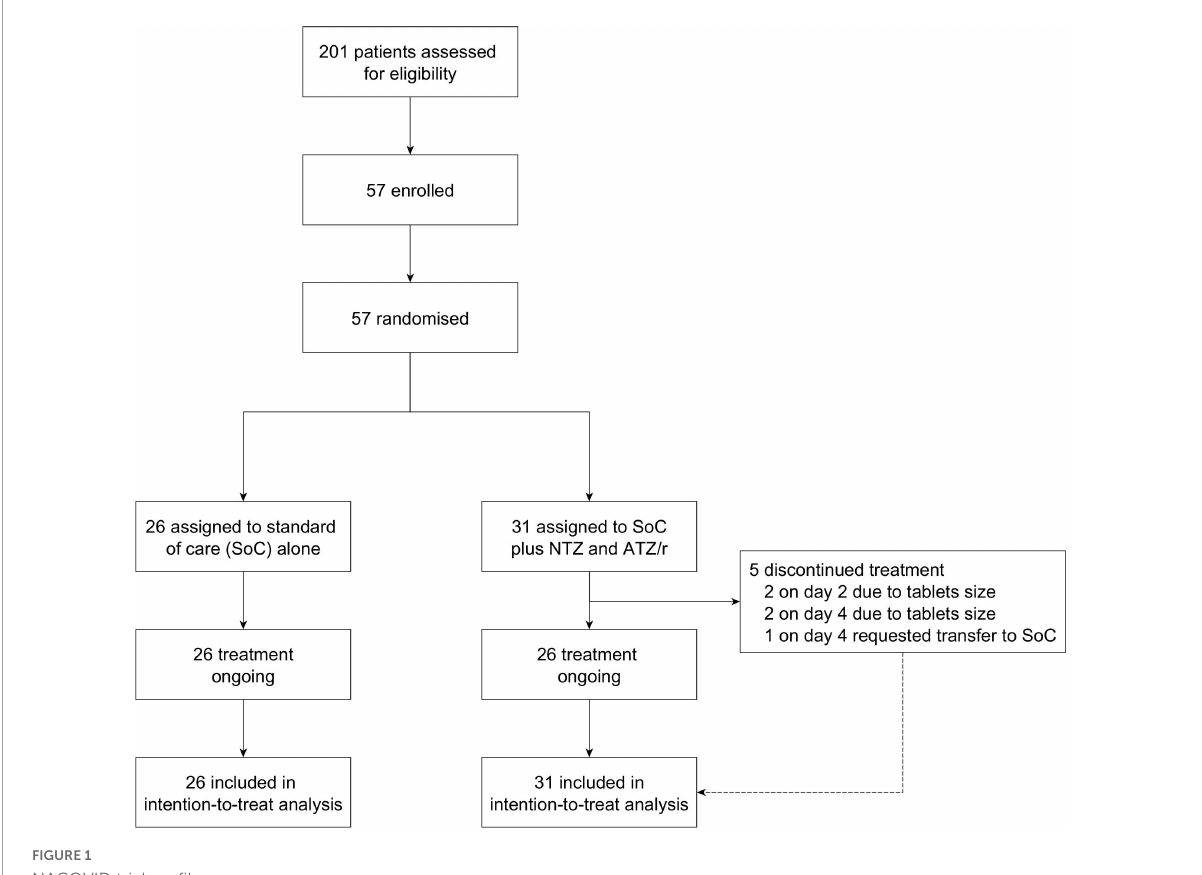
FIGURE1 NACOVID trial